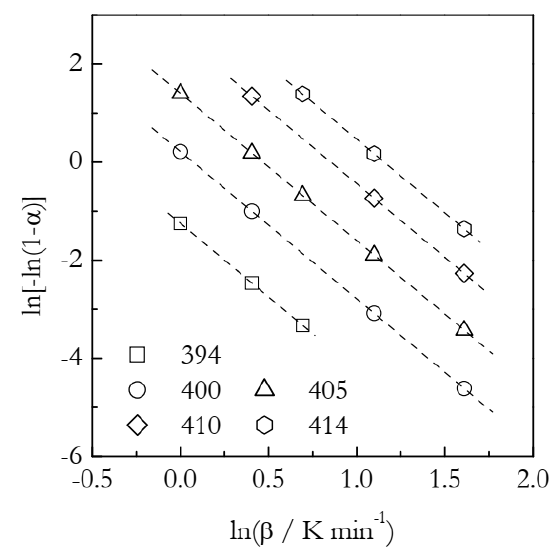
Figure 2. Ozawa plots for the A3 process. Numbers by the symbols are temperatures in K. Dash lines are least square fits to the respective points.